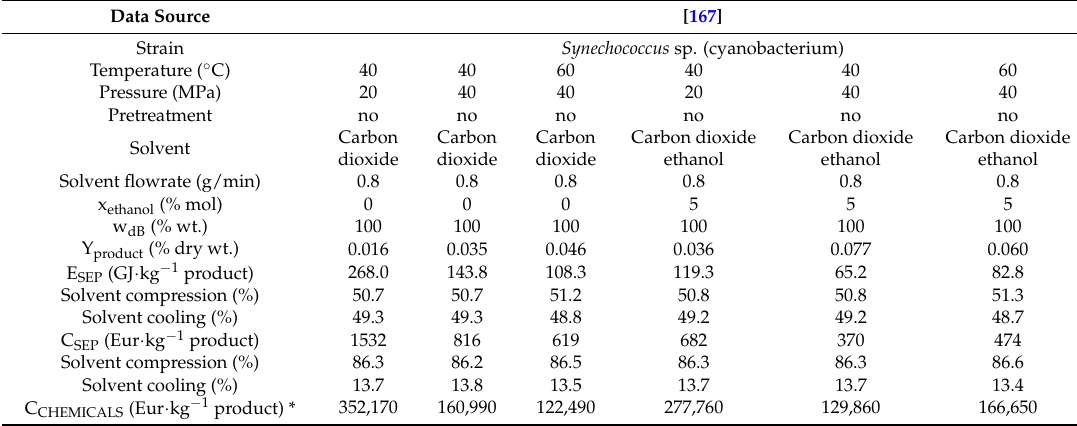
Table 5. Energy requirement, energy and production costs for β -carotene extraction.